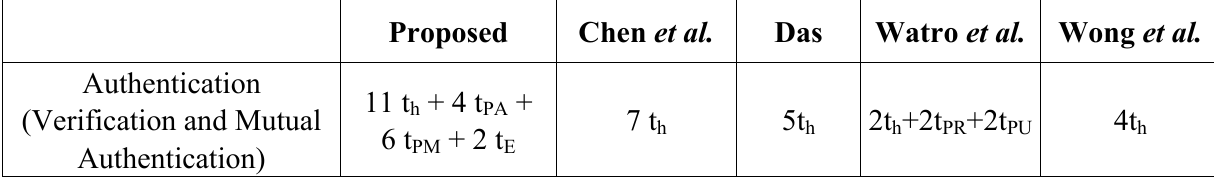
Table 3. Performance comparison among related